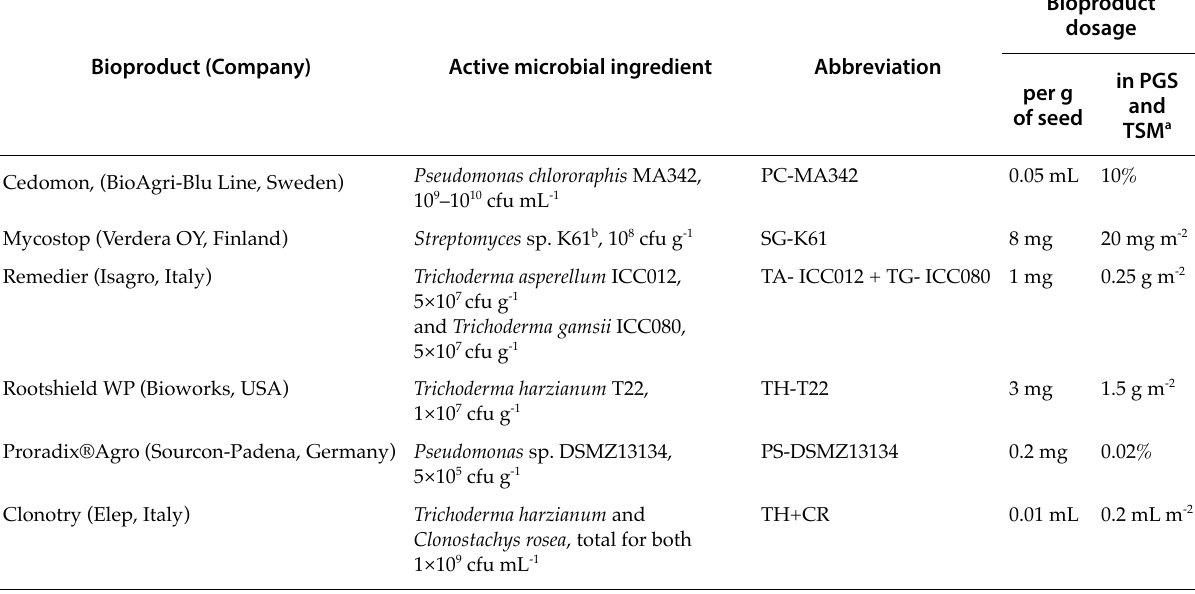
Table 1. Bioproducts, active microbial ingredients (antagonists) and their abbreviations, and dosages used in biocontrol activity and rhizosphere colonization assays.